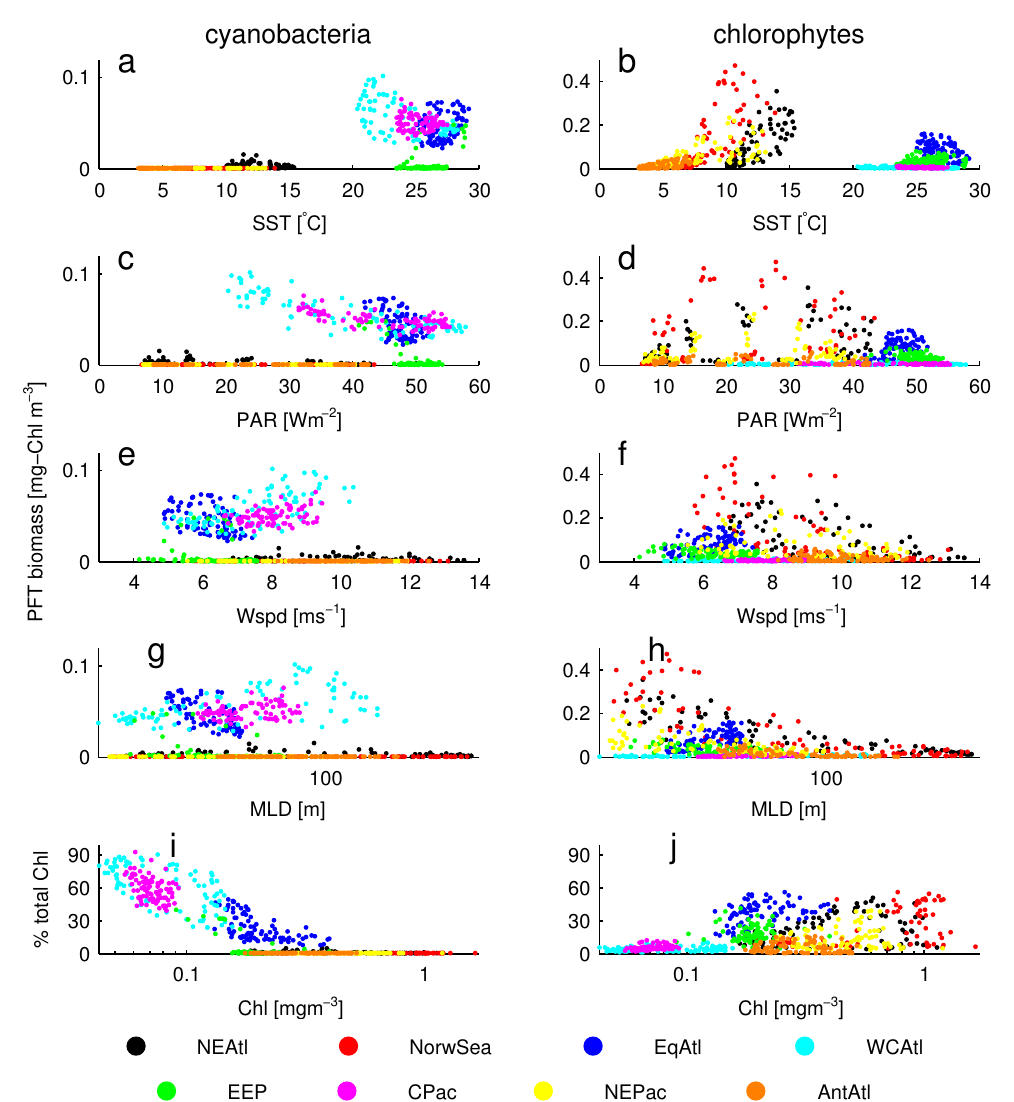
Fig. B2. Scatter plots showing the emerging relationship between NOBM cyanobacteria (left column) and chlorophyte (right column) biomass [mgChlm − 3 ] (a–h) or % of total Chl (i, j) vs. individual ecological indicators color coded according to domain of origin. On the x axis from top to bottom: SST, PAR, Wspd, MLD and Chl. All data points come from exploratory analysis only, and thus they are box average and monthly average estimates from October 1997 to December